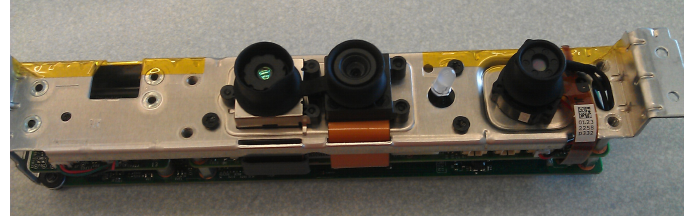
Figure 7. Stripped Microsoft